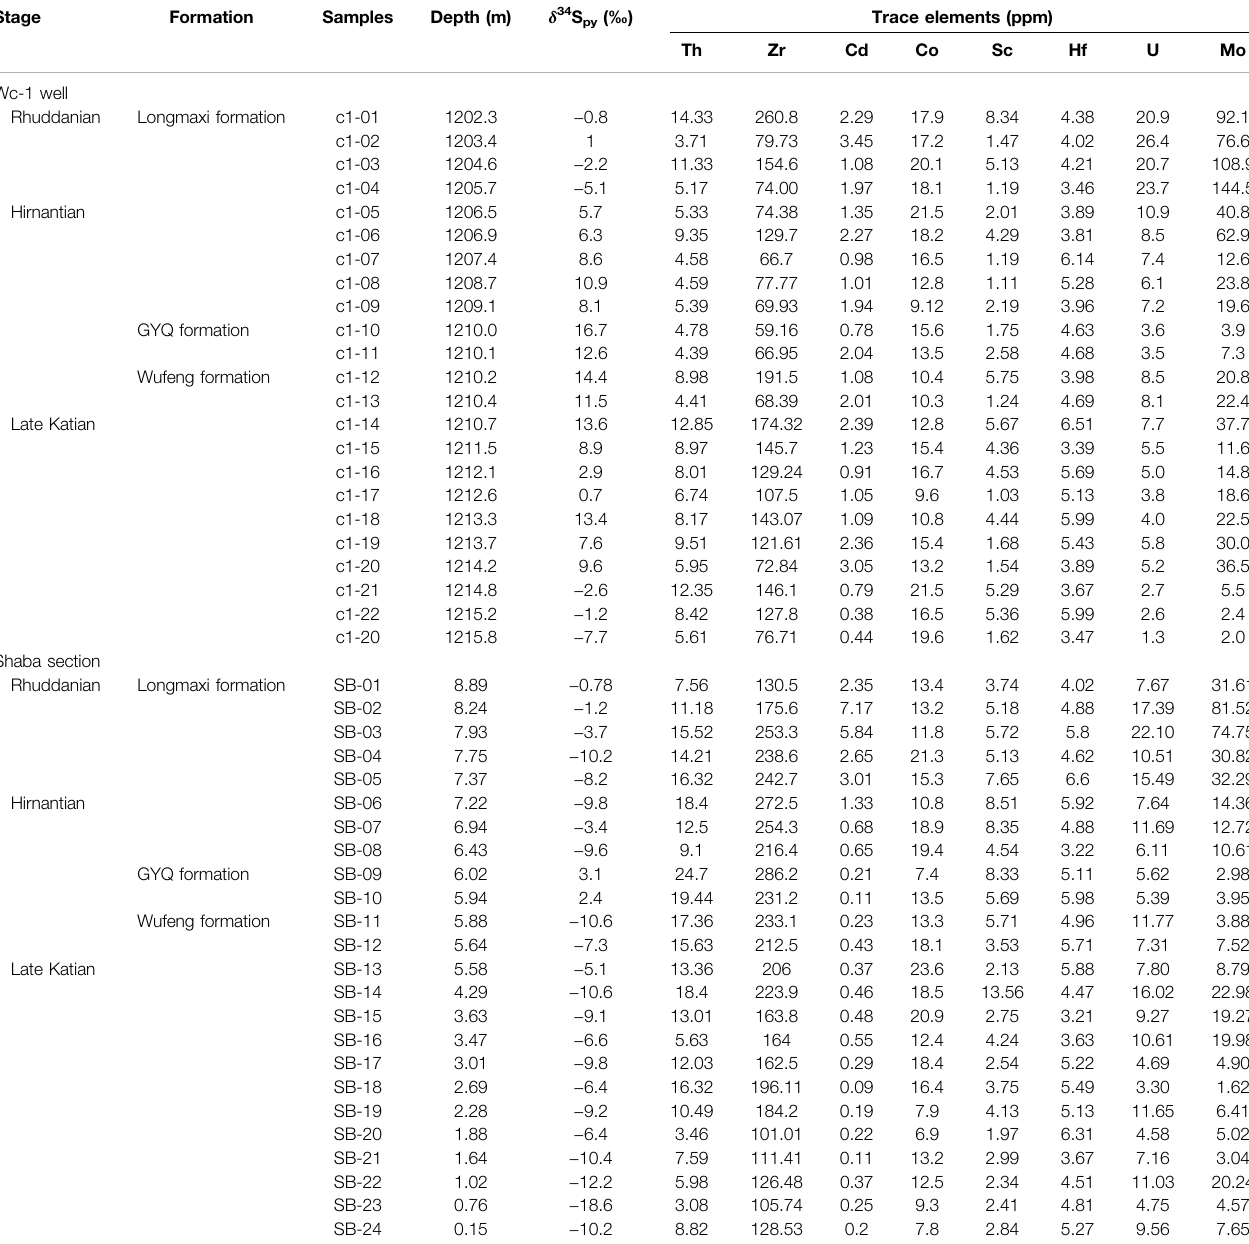
TABLE 2 | Test results of δ 34 S py and trace elements in Wc-1 well and Shaba section. Stage Formation Samples